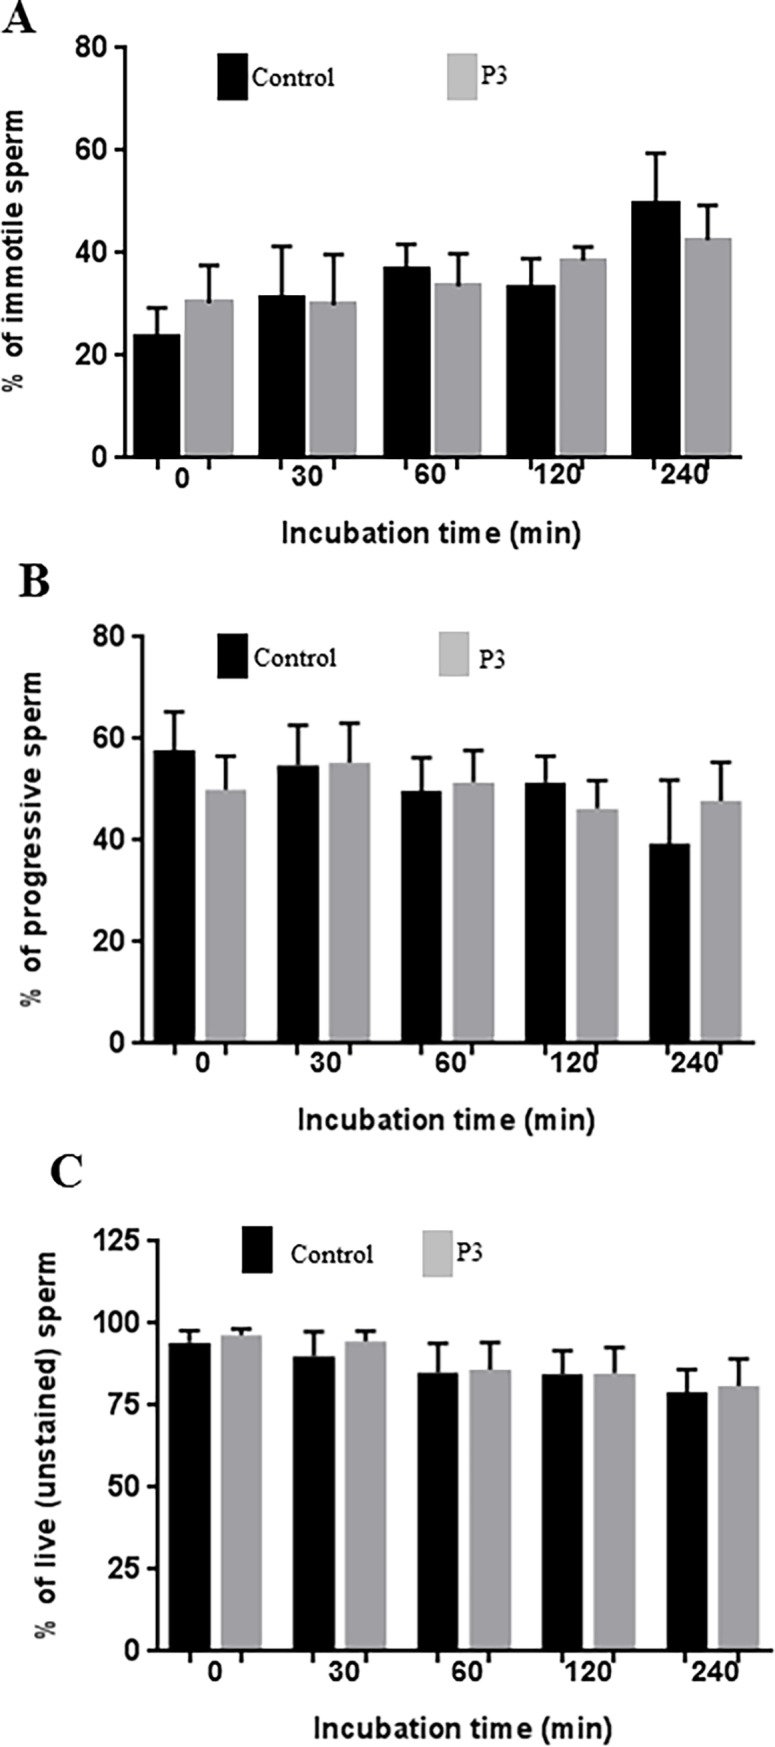
Effect of P3 in human spermatozoa motility and viability.Motility and vitality were assessed at different time intervals (0, 30, 60, 120 and 240 min). (A) Percentage of immotile sperm in the presence or absence (control) of P3; (B) Percentage of progressive sperm in the presence or absence (control) of P3; (C) Percentage of live sperm in the presence or absence (control) of P3. No differences (p>0.05) were observed between control group (drug vehicle) and P3 treated group, for each incubation time.